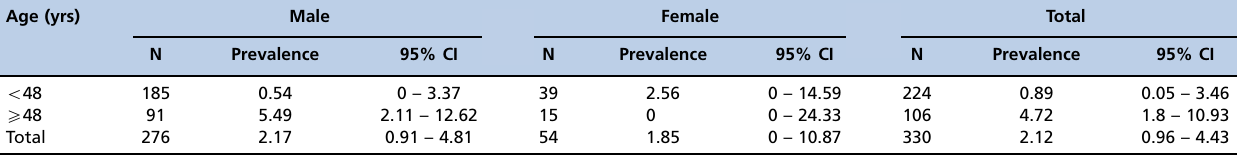
Table 1 - Prevalence of Cholelithiasis (and 95% Confidence Interval) by Sex and Age – Violent Death. Age (yrs)